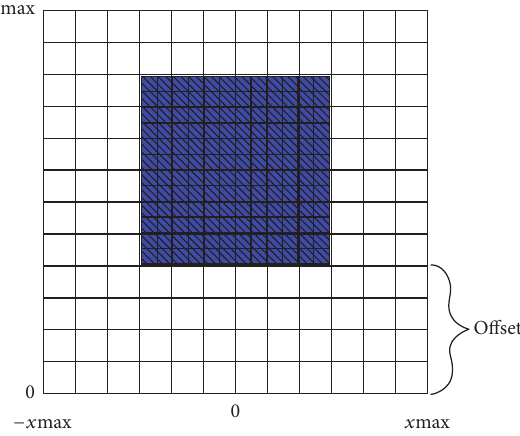
Figure 1: Schematic representation of the field and hydrodynamics grid used in the simulations. The inner blue grid represents the higher resolution matter grid and the outer white grid represents the field grid.